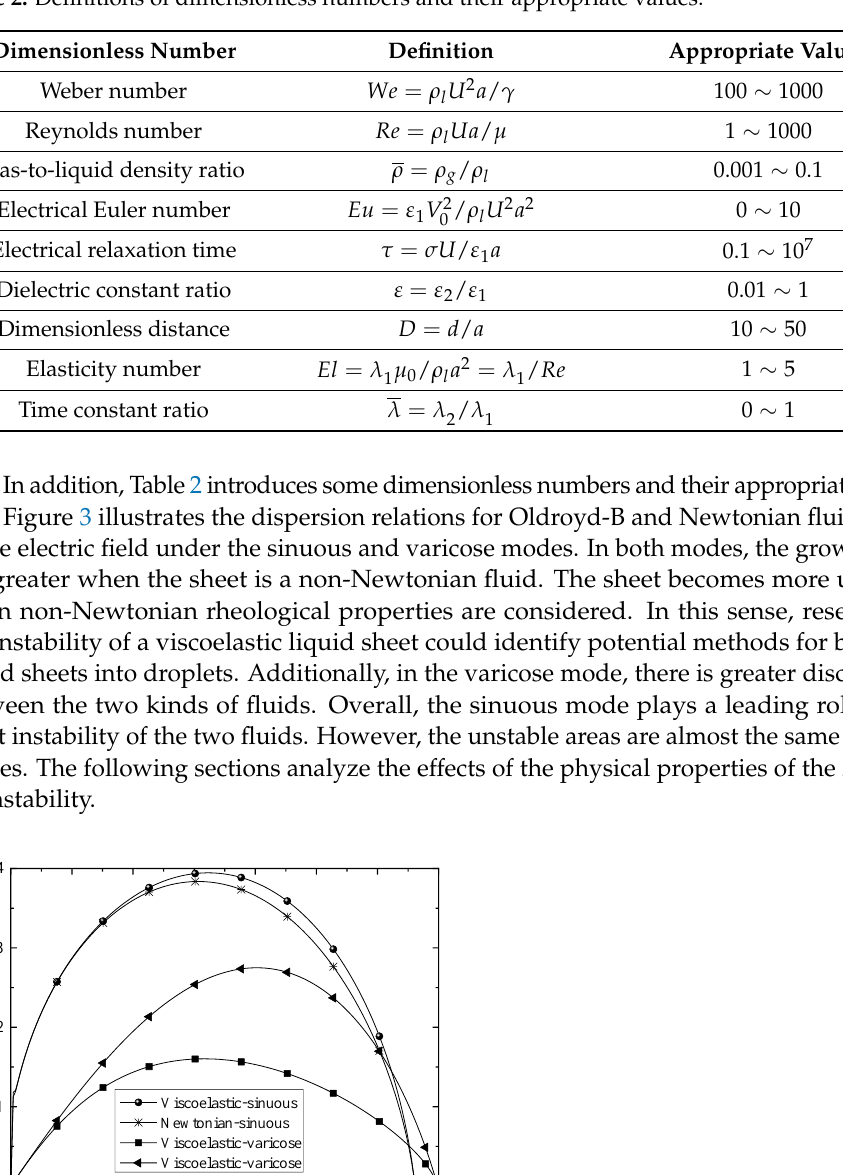
Table 2. Definitions of dimensionless numbers and their appropriate values.